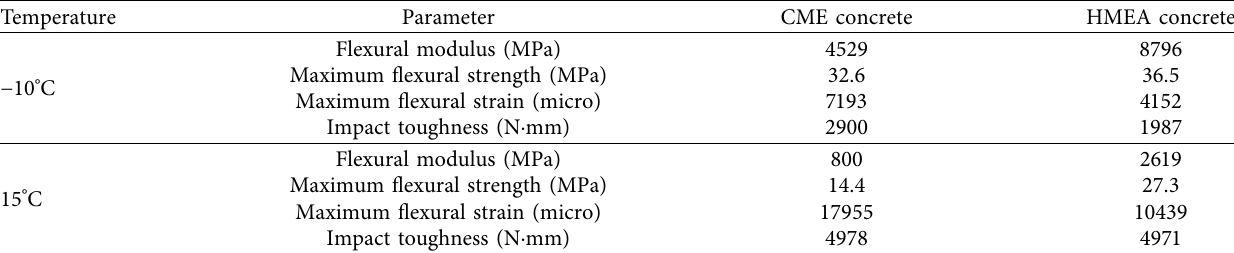
Table 14: The three-point bending test results of CME and HMEA concrete.